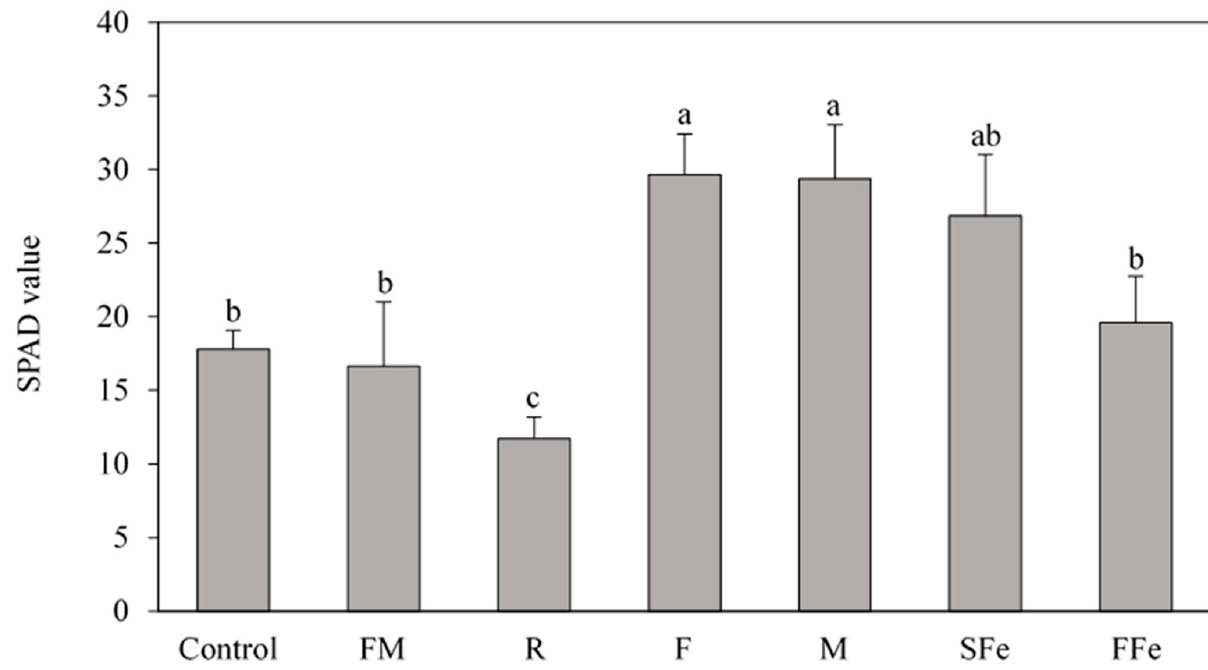
Figure 3. The soil plant analysis development (SPAD) values of HG-QA leaves grown in different practices. HG-QA: “Huangguan” pear grafted onto quince A. Control: ridging with landscape fabric mulching and without other treatments; FM: flattening with landscape fabric mulching, R: ridging without landscape fabric mulching; F: flattening without landscape fabric mulching; M: Manure application; SFe: Fe application in soil; FFe: Foliar Fe application. The different letters mean statistical differences between treatments, p < 0.05 (Benjamini–Hochberg correction).